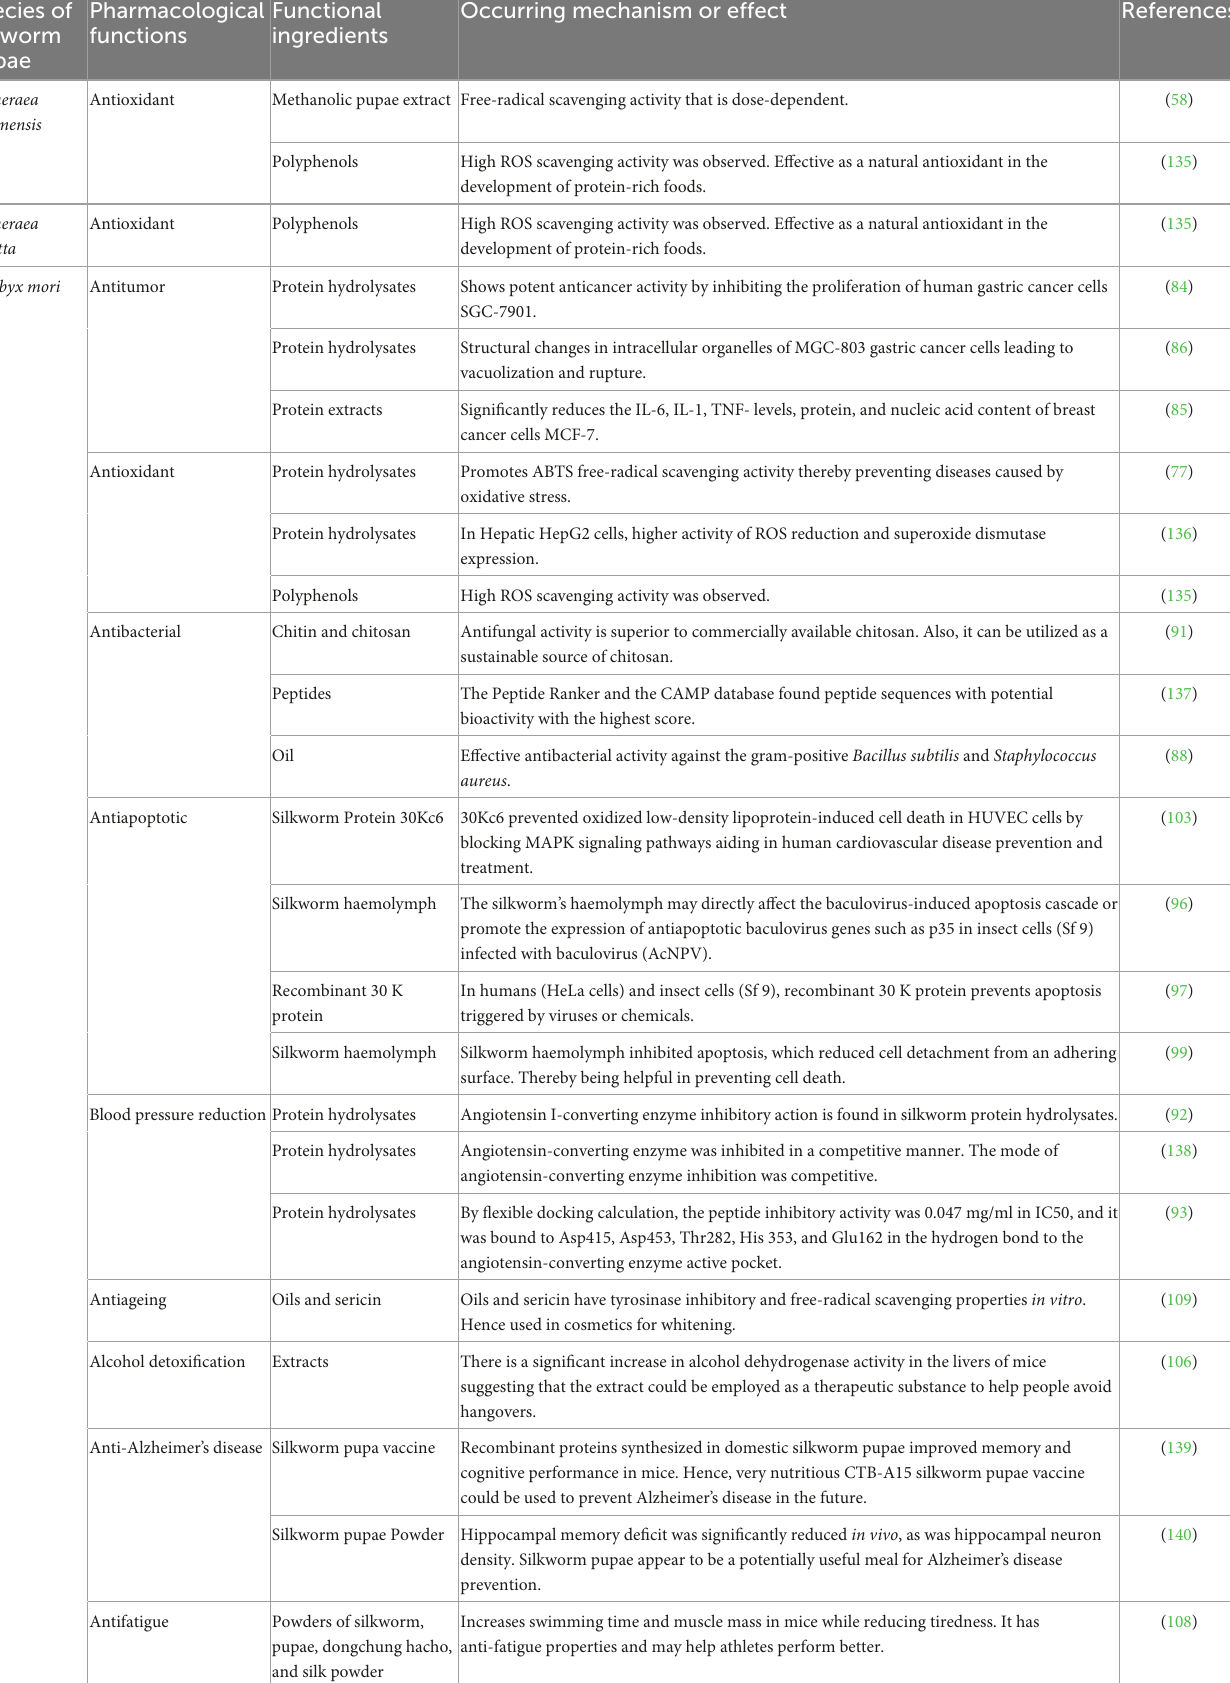
TABLE 1 Representing pharmacological functions of different species of silkworms, functional ingredients present in pupae and mechanisms involved with different pharmacological